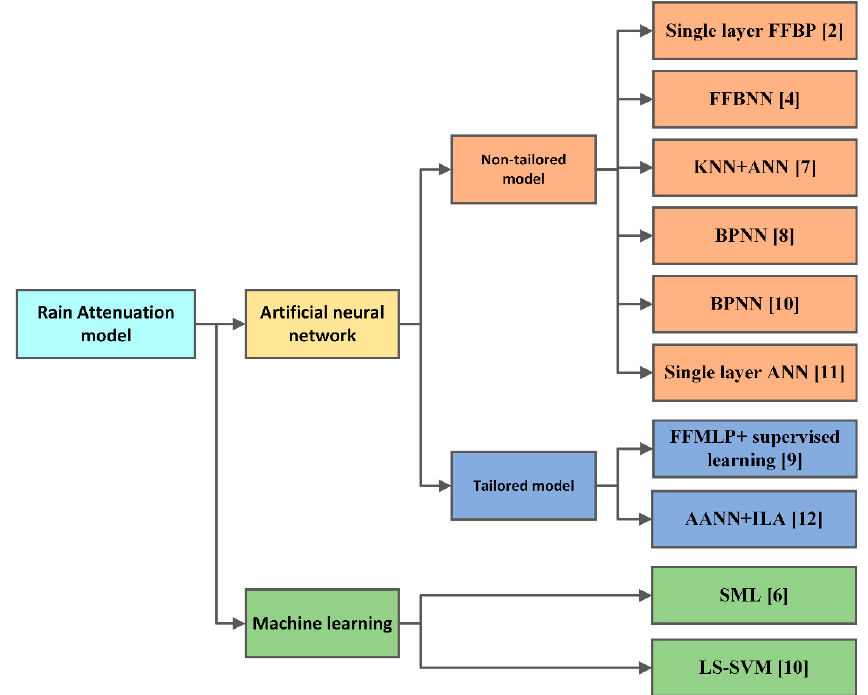
Figure 3. LARA model’s taxonomy based on the model structure or formation.